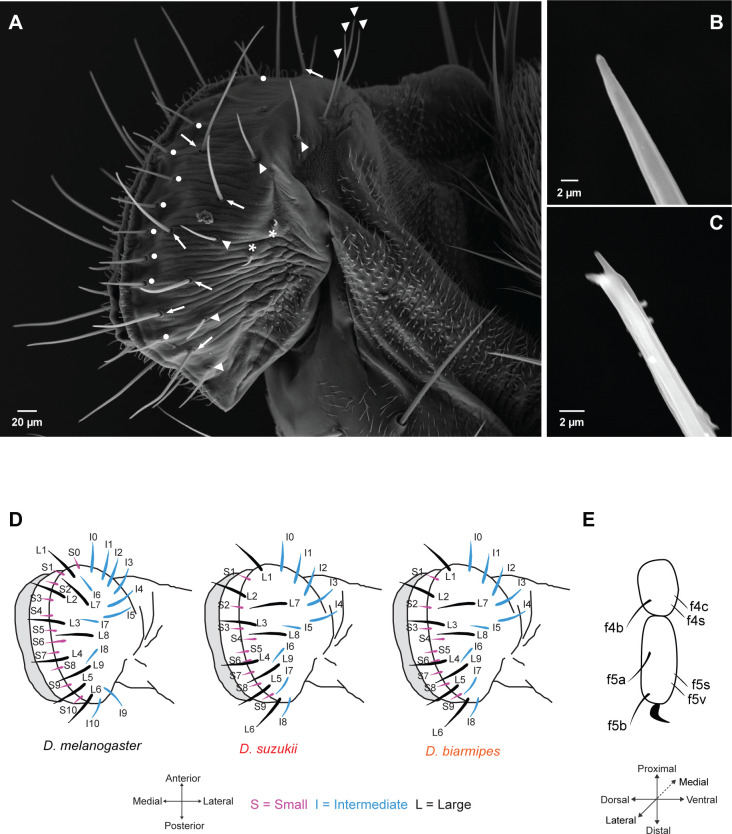
Taste sensilla on the labellum and leg.(A) Scanning electron micrograph of the labellum of D. suzukii showing short taste sensilla (white dots), intermediate taste sensilla (white arrowheads), long taste sensilla (white arrows), and sensilla that have no terminal pores (asterisks). (B) Scanning electron micrograph of an intermediate taste sensillum with a straight tip. (C) Scanning electron micrograph of a long taste sensillum with a forked tip. (D) Maps of labellar taste sensilla in the three species. (E) Map of taste sensilla on the two most distal tarsal segments of the female foreleg; the map applies to all three species.